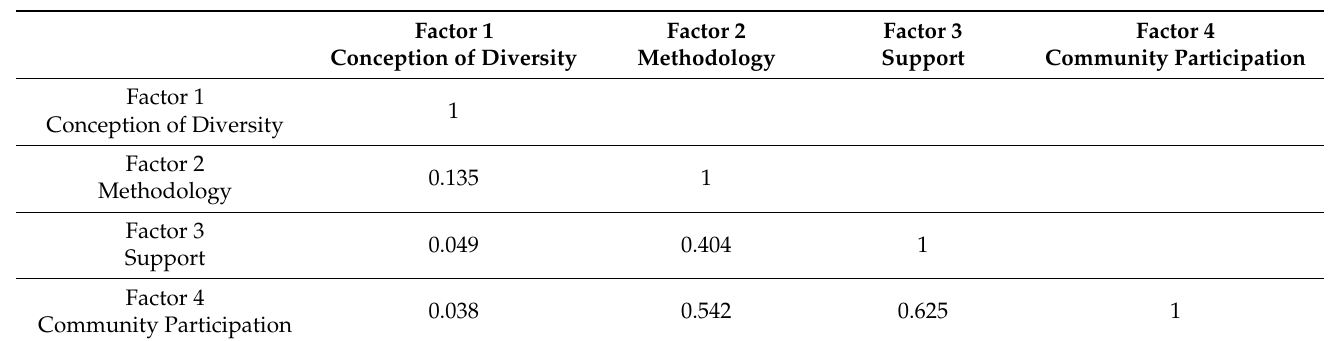
Table 5. CEFI-R questionnaire inter-factor correlation